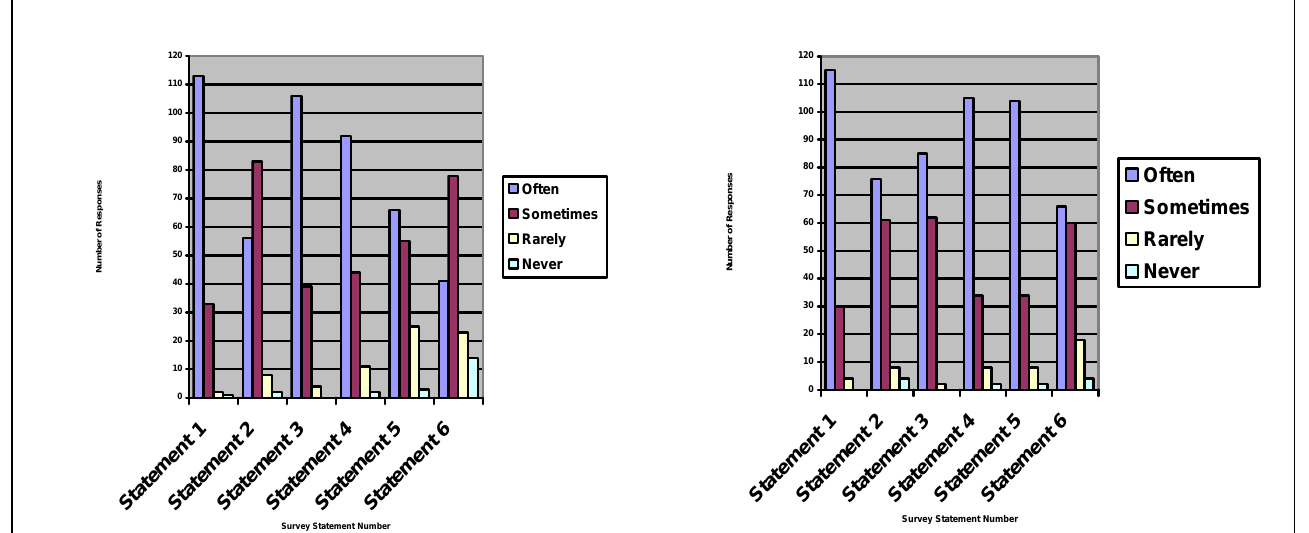
Figure 17: Comparison of Pre and Post Student